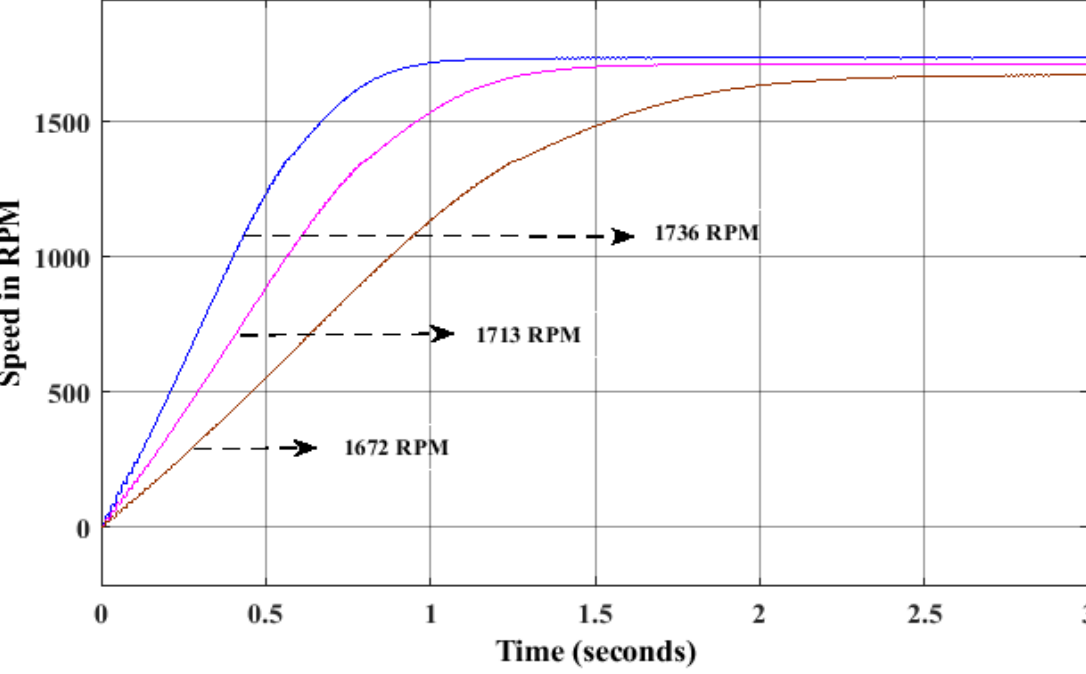
Figure 13. Various speed responses of the induction motor with respect to different input voltages.